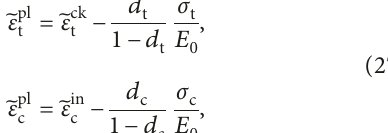
Figure 18: Yield surface in deviatoric plane, corresponding to different values of K c [51].